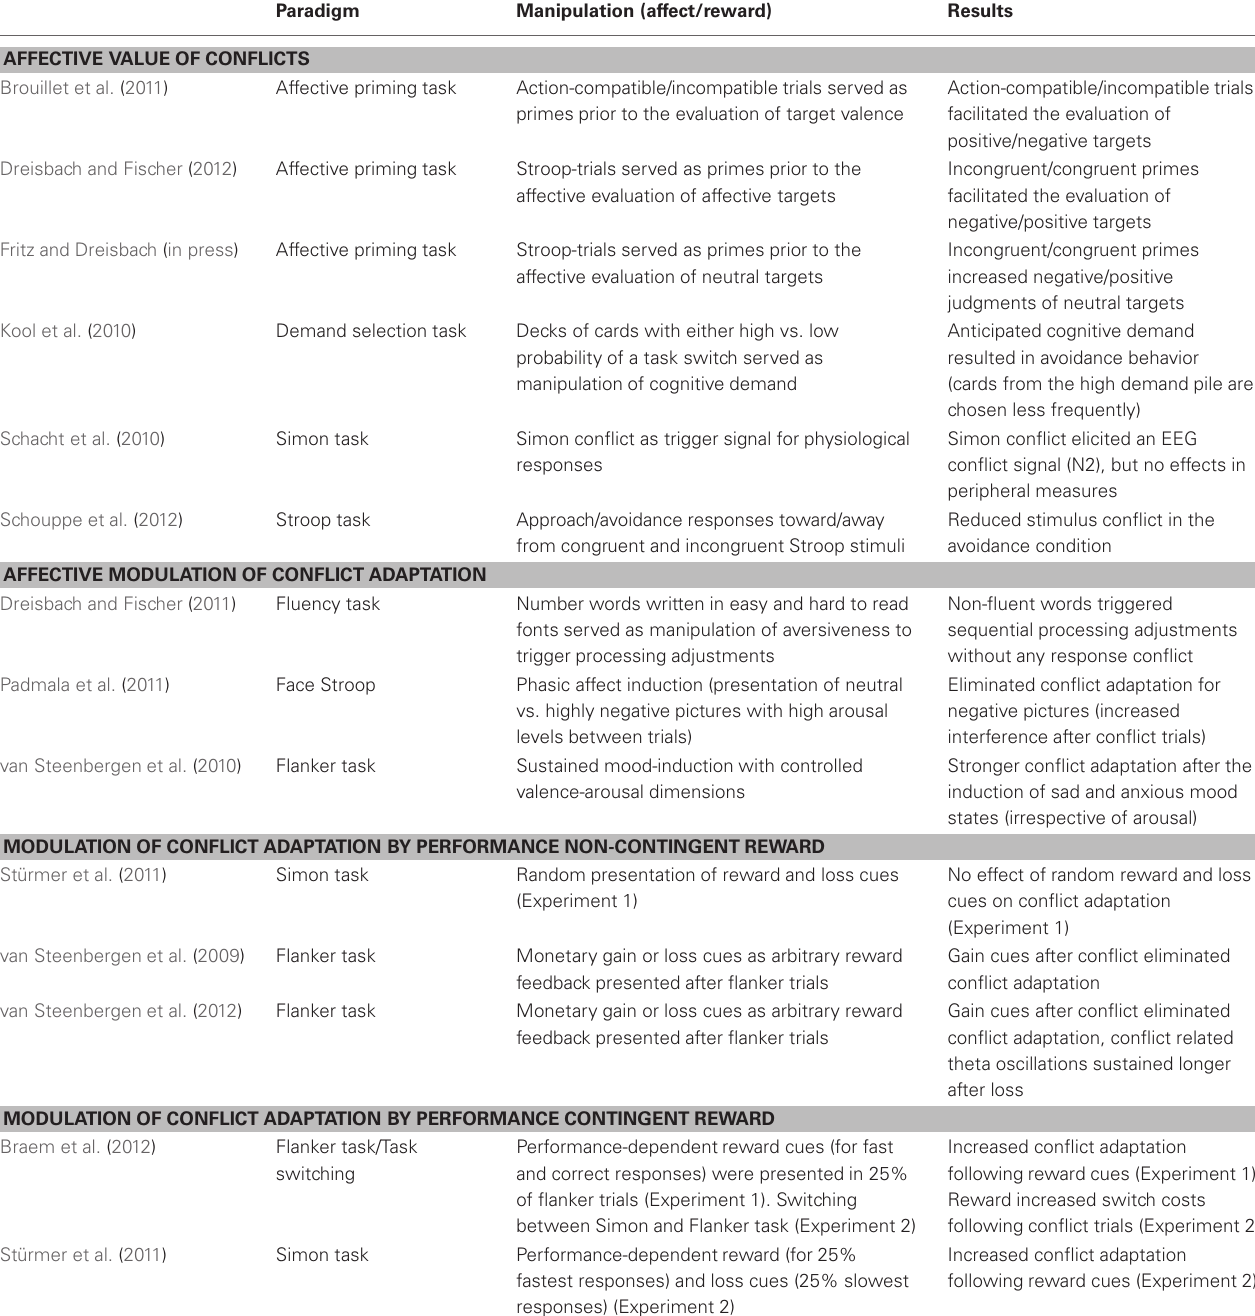
Table 1 | Overview of the reviewed